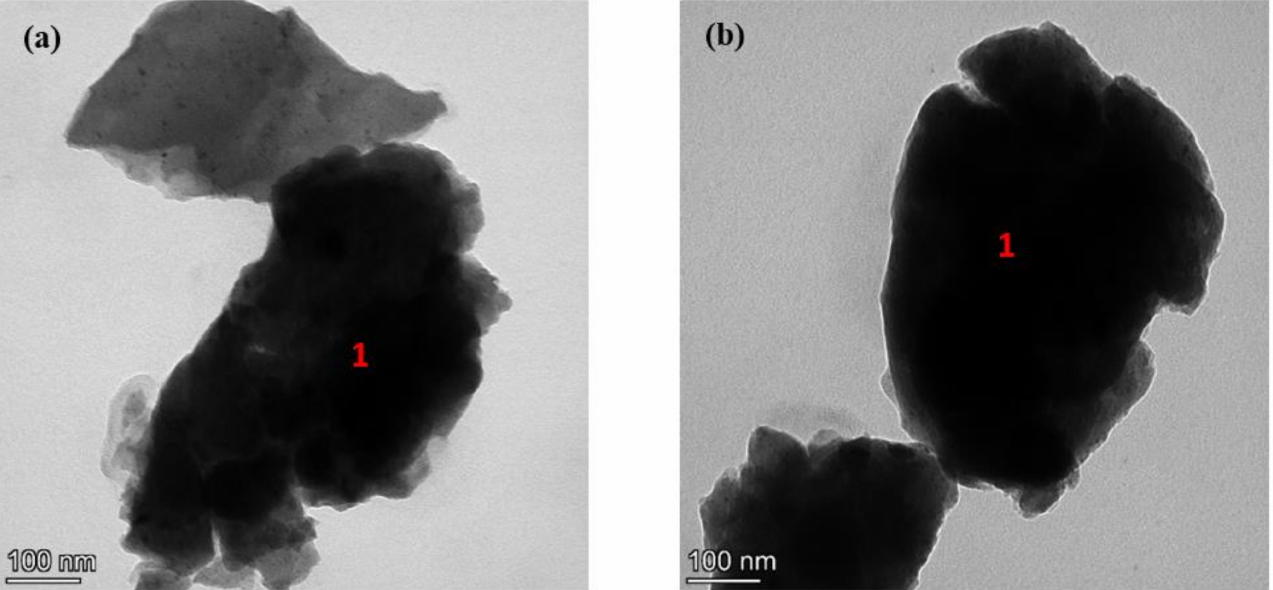
Figure 14. TEM images of a cluster of particles that were collected from the counterface ( a ), the WC-CoCr coating, and ( b ) the WC-FeCrAlY